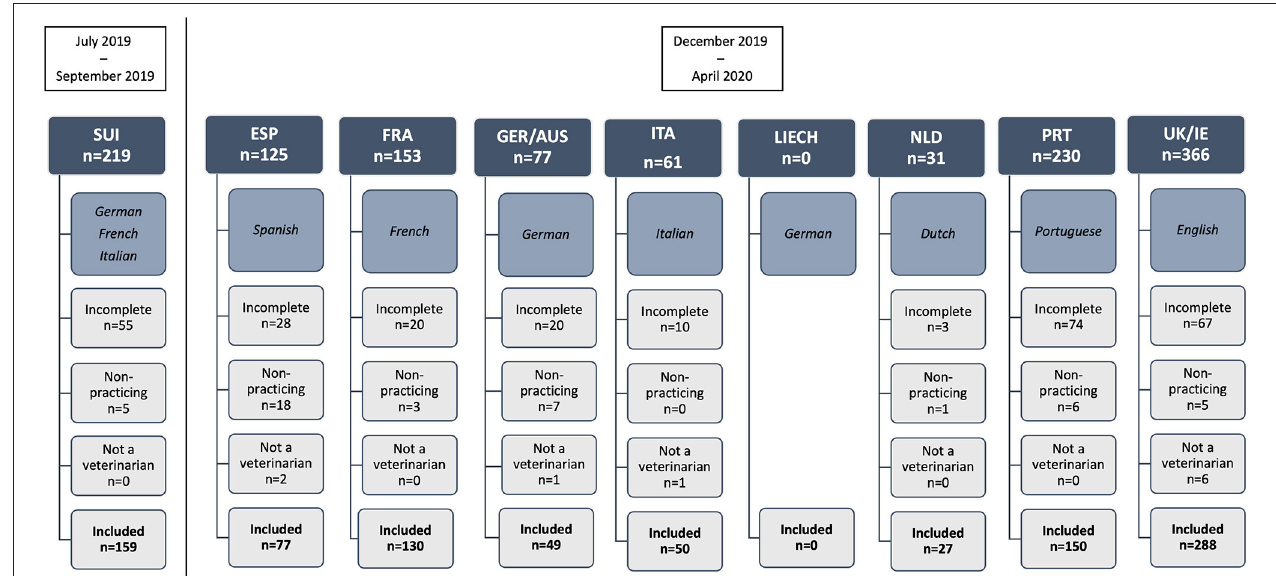
FIGURE 1 | Flow diagram showing language of survey dissemination and number of survey respondents by European region, and reason for inclusion or exclusion in the final study. ESP, Spain; FRA, France; GER/AUS, Germany/Austria; ITA, Italy; LIECH, Liechtenstein; NLD, Netherlands; PRT, Portugal; SUI, Switzerland; UK/IE, England/Northern